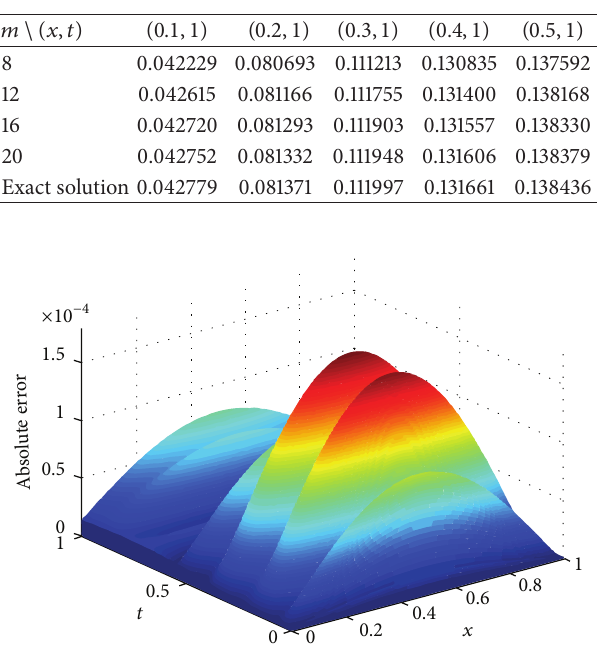
Table 1: Some numerical and exact solutions at 𝑡 = 1 .